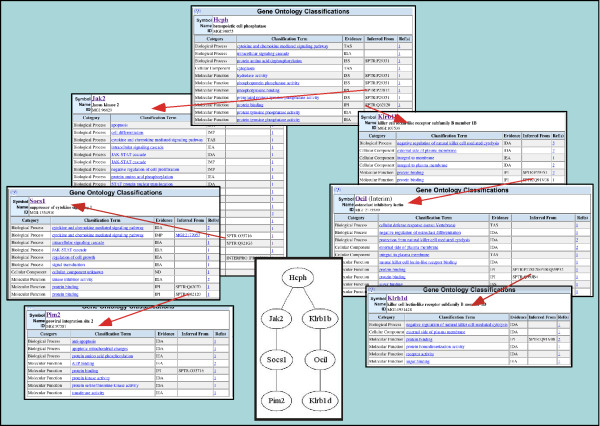
Construction of a simple protein interaction network using GO annotations to protein binding.